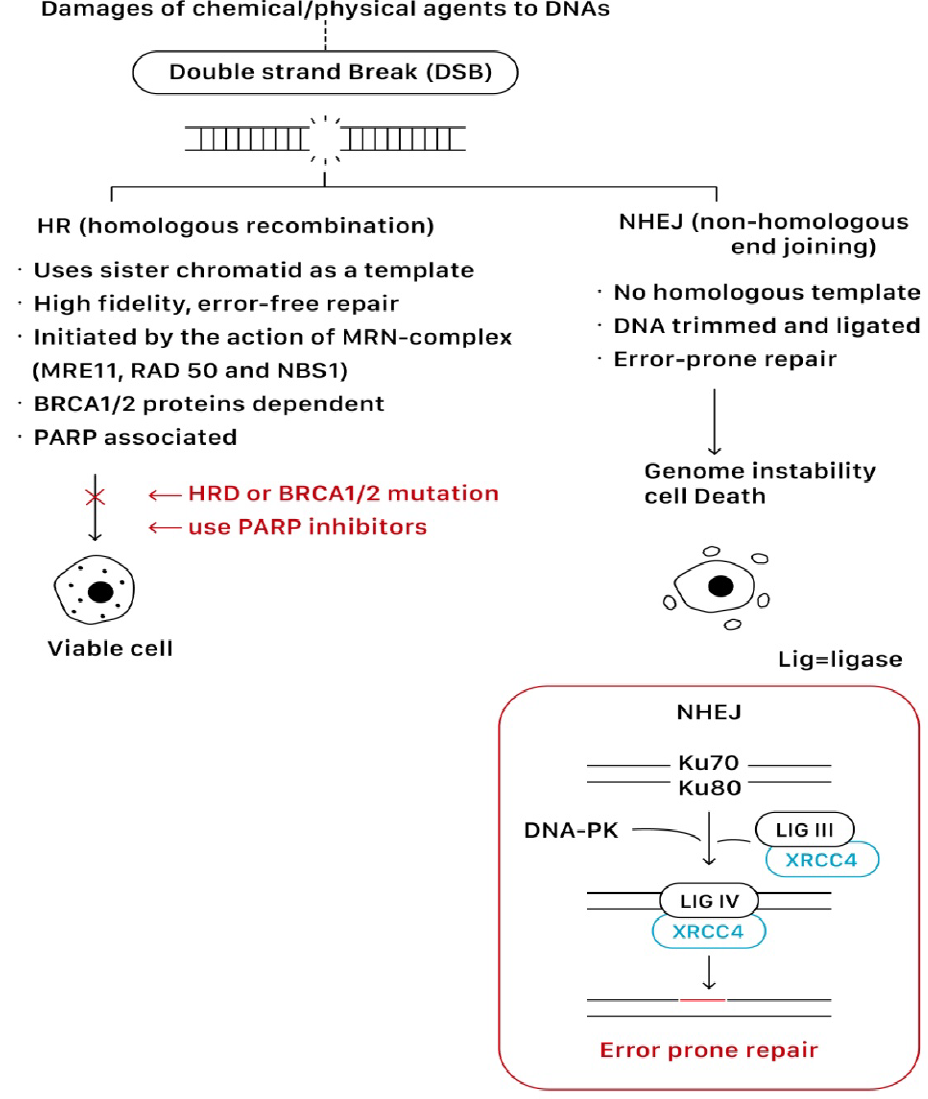
Figure 4. The repairing process of DSBs via the HR and NHEJ pathways.